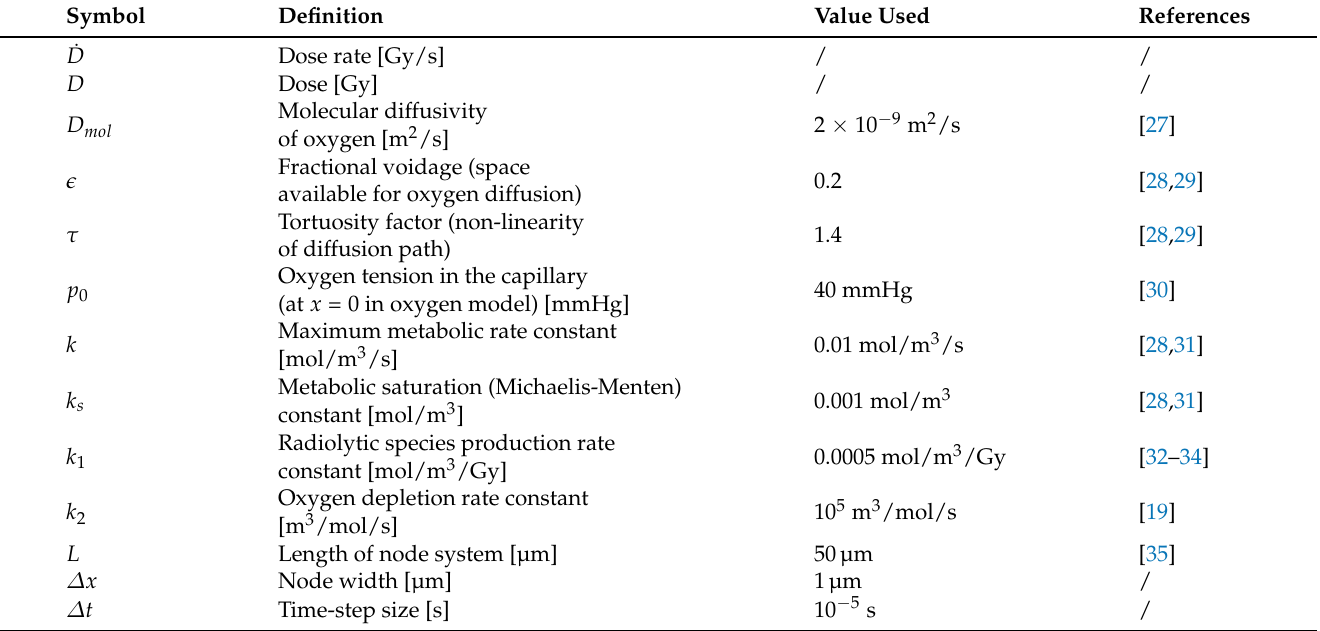
Table 1. Parameter definitions and values used in